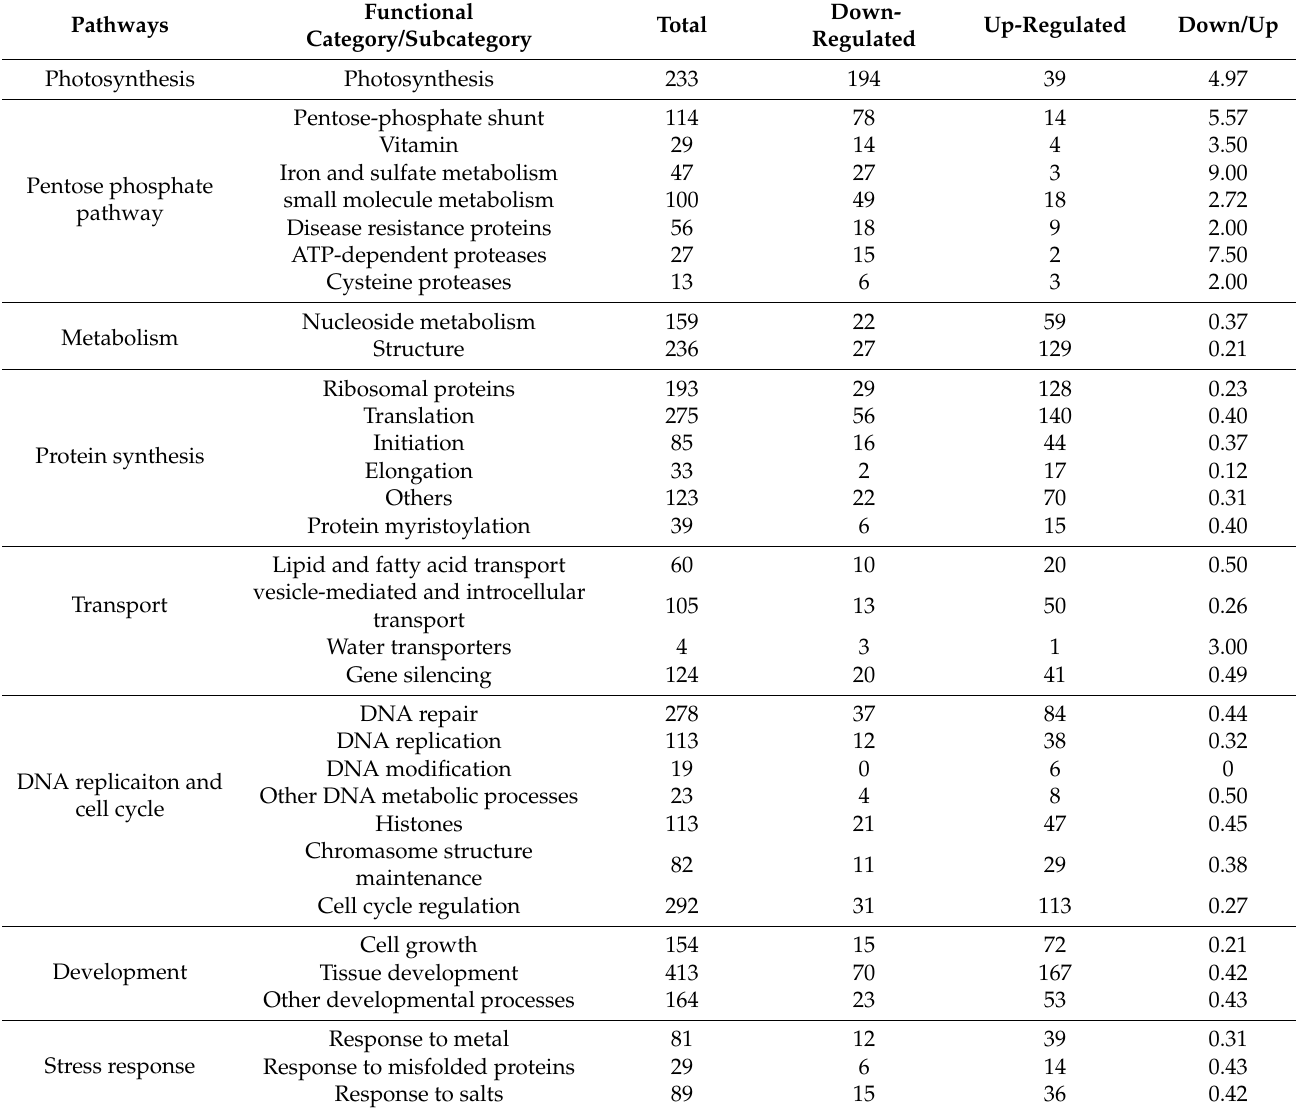
Table 3. The up- and down-regulated pathways in gall vs. LWG (based on KEGG pathway). Pathways